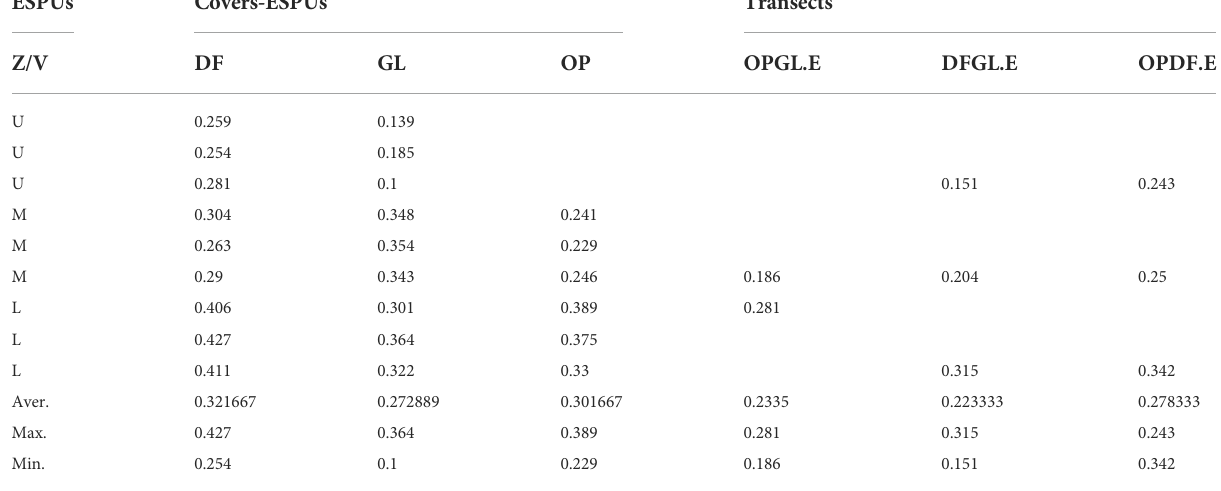
TABLE 3 ES indicator estimation of the soil carbon storage. ESPUs